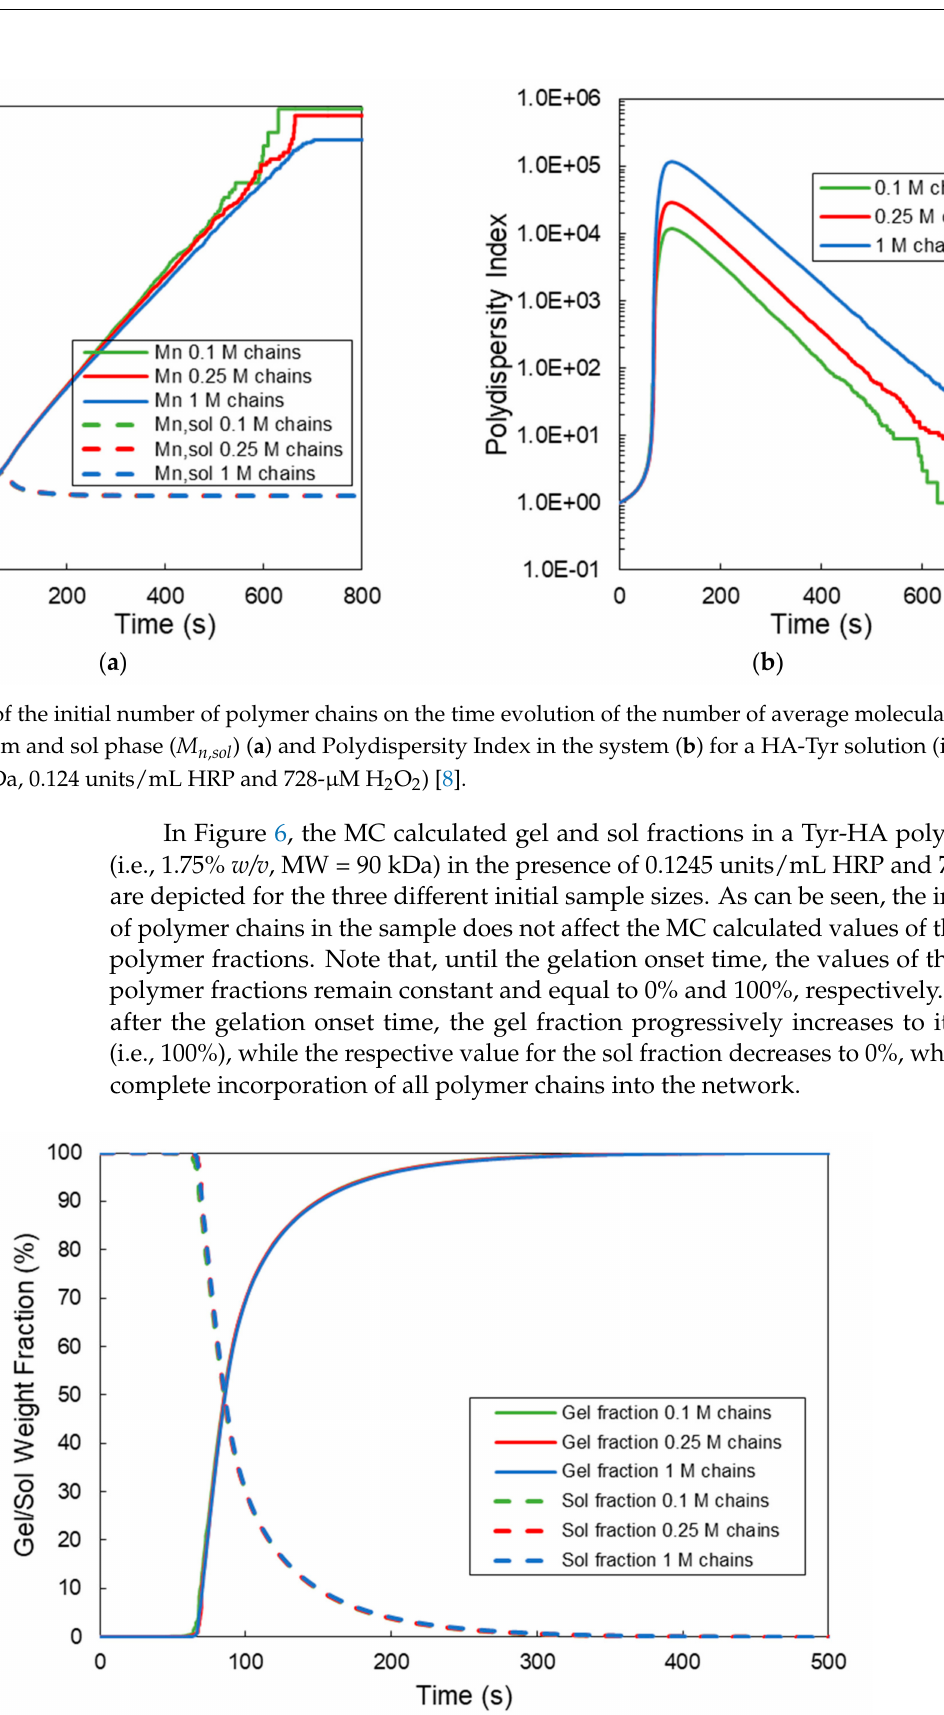
Figure 6. Effect of the initial sample size on the time evolution of the sol and gel mass fractions for a HA-Tyr solution (i.e., 1.75% w/v , MW = 90 kDa, 0.124 units/mL HRP and 728- µ M H 2 O 2 )